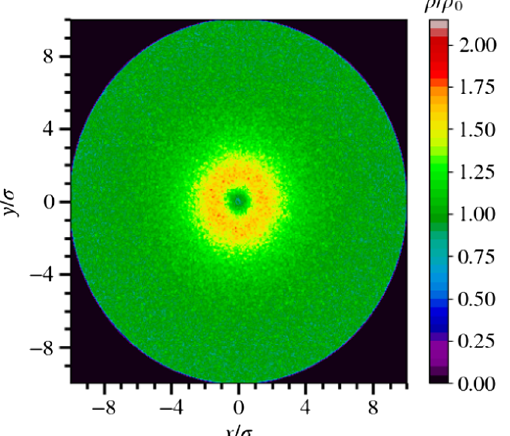
FIG. 26. Simulated density based on a rigid-molecule model, for a temperature T=T (cid:3) p ¼ 0 . 1 , at the normalized time n which is approximately the moment of maximum peak density. The picture presents a snapshot of the molecule distribution in the x - y plane. The molecule density is normalized with respect to the initial (or space-averaged) molecule density. The par- ticles are initially distributed uniformly throughout the trans- verse x - y plane. For this simulation, we tracked 1 . 2 × 10 7 molecules with L 2 = σ 2 ¼ 10 − 5 . The density is estimated on a grid of 400 × 400